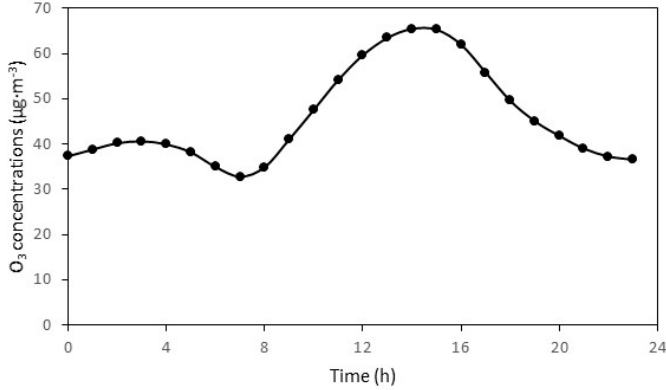
Figure 3. Daily average profile of O 3 concentrations at the monitoring site.